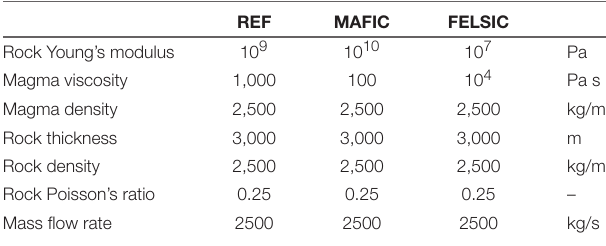
TABLE 2 | Input parameters used for the simulations shown in Figure 11